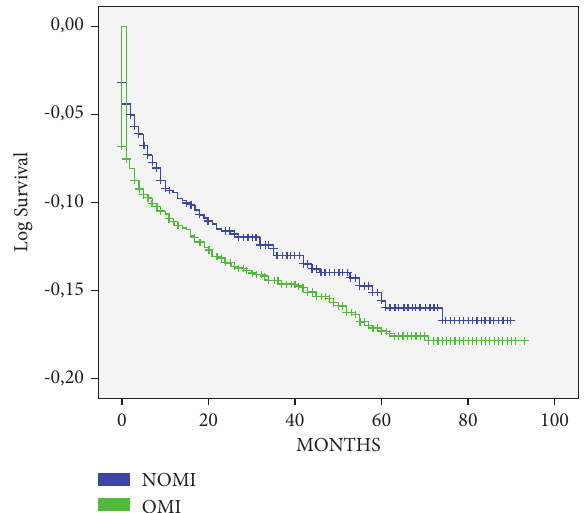
Figure 1: Cardiovascular mortality during follow-up period. NOMI, nonocclusive myocardial infarction; OMI, occlusive myocardial infarction.